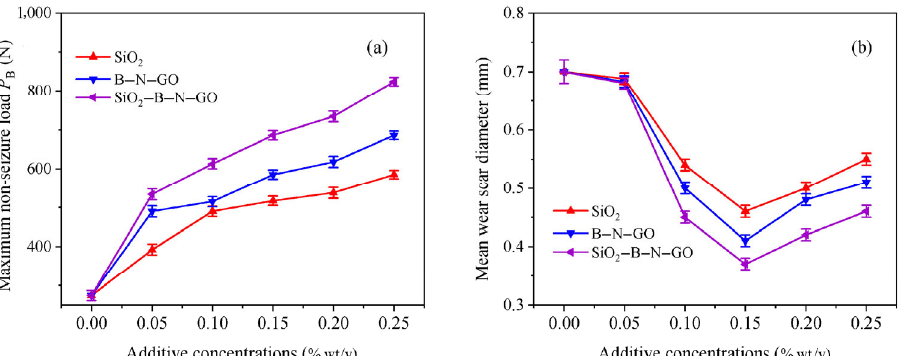
Fig. 6 Variations of the (a) maximum non-seizure load ( P B ) and (b) mean wear scar diameter (392 N, 60 min) for the base oil with increasing additive concentrations.